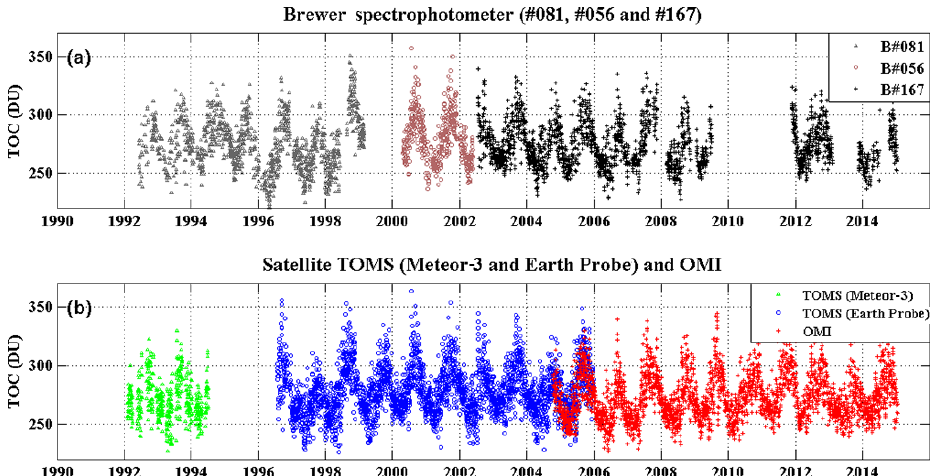
Figure 1. Schematic diagram of the TOC time series for each instrument (Brewer and satellite) at the Southern Space Observatory (SSO) between 1992 and 2014. (a) Brewer spectrophotometer (#081 in grey triangles, #056 in brown circles and #167 in black crosses) and (b) TOMS (Meteor-3 in green triangles and Earth Probe in blue circles) and OMI (in red crosses) satellite instruments.